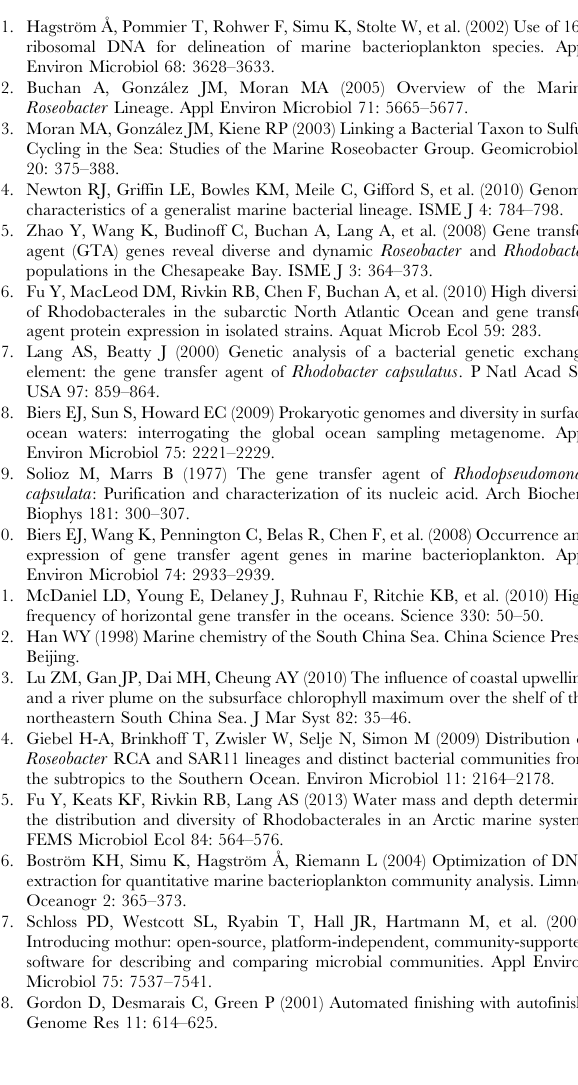
Table S2 Comparison of g 5 gene OTUs composition and distribution in four clone libraries. Table S3 Comparison of g5 gene cluster and distribu- tion in the